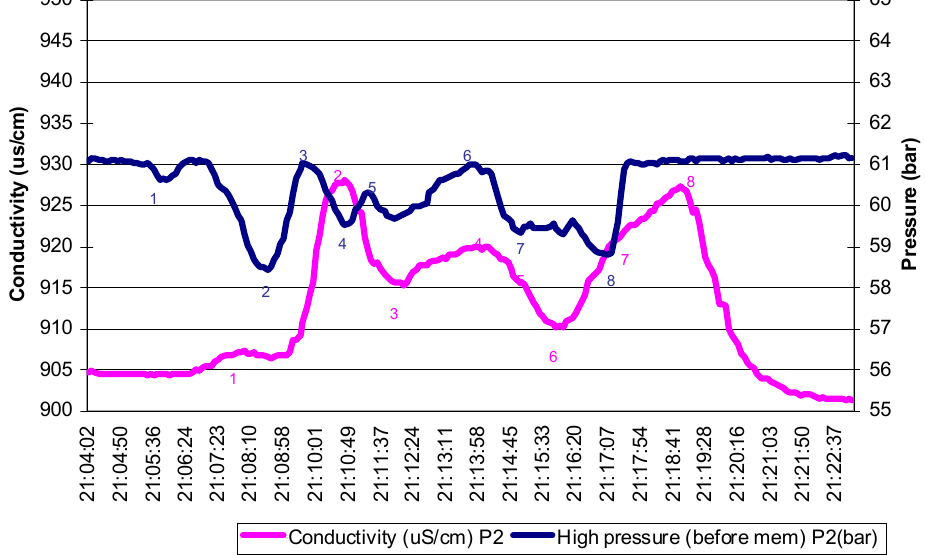
Figure 3. Evolution of the pressure inlet to the membranes and the product water conductivity under a variable power supply period.